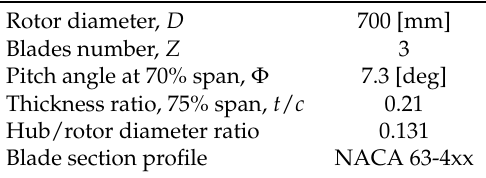
Table 1. IFREMER-FP turbine main geometry parameters.